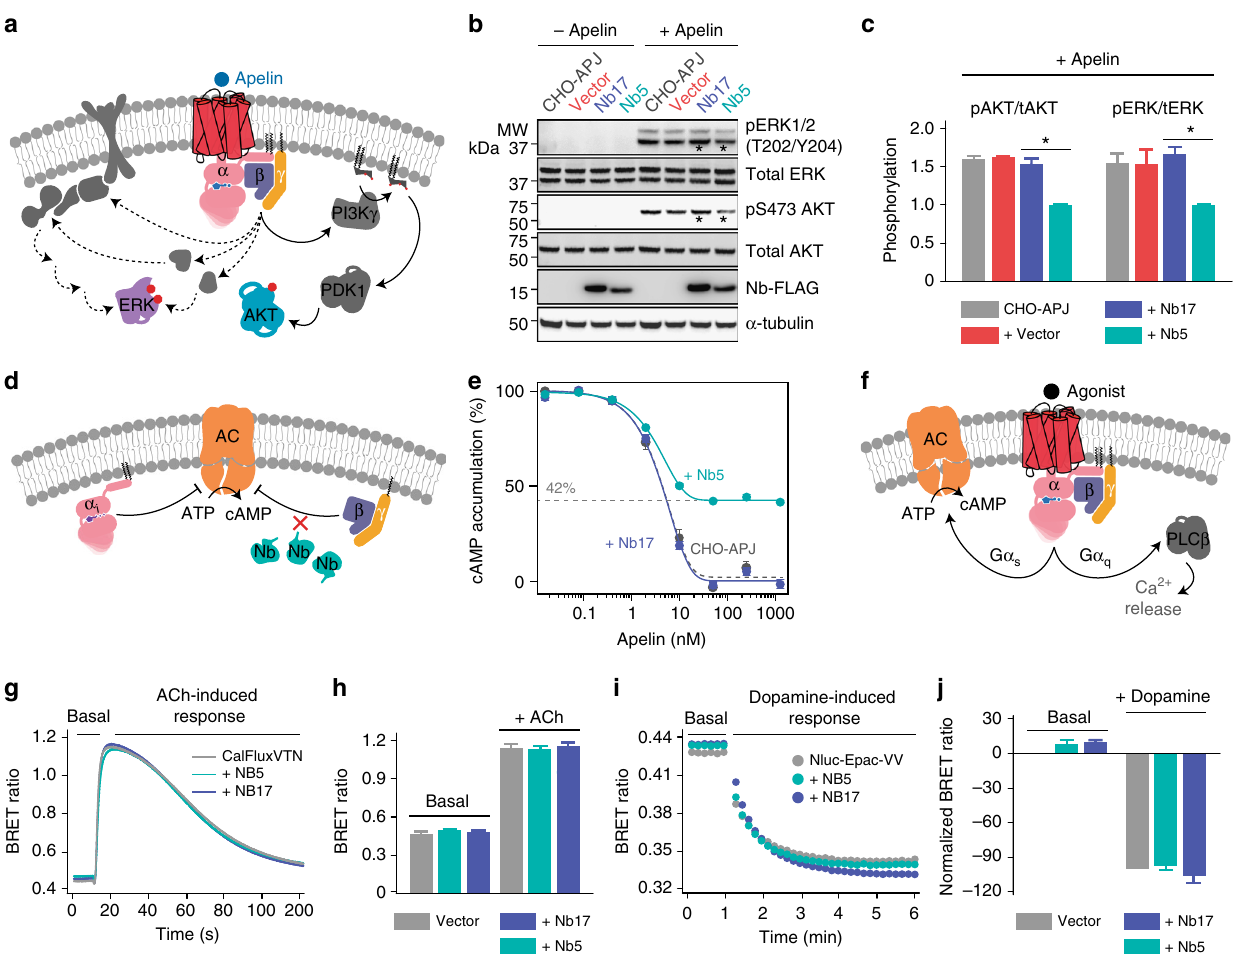
Fig. 6 Nb5 as a control-switch for GPCR-mediated G βγ signaling. a Schematic diagram of the GPCR-mediated G βγ signaling network that controls various cellular functions. b Parental CHO-APJ cells, CHO-APJ cells transfected with pcDNA3.1 ( + ) empty vector, transfected CHO-APJ-Nb5 and CHO-APJ-Nb17 cells were treated with 1 μ M apelin over 0 – 5 min to investigate the effect of Nb5 on the phosphorylation of ERK1/2 and AKT. Nb5 signi fi cantly decreased the phosphorylation of both ERK1/2 and AKT as compared to the Nb17 control (compare lanes marked with asterisks). Full blots are reported in Supplementary Figure 4b. c No signi fi cant effect of Nb17 transfection (purple) was observed on the phosphorylation of either ERK1/2 or AKT as compared to parental CHO-APJ cells (black) and CHO-APJ cells transfected with pcDNA3.1 ( + ) empty vector (red). Results are expressed as the mean ± SEM, n = 3 replicates, * P < 0.05, Student ’ s t -test. d Schematic diagram showing the effect of G α i and G βγ signaling on cellular cAMP levels. e Dose-response curves of apelin-induced inhibition of cAMP accumulation in parental CHO-APJ cells (grey) and CHO-APJ cells expressing either Nb5 (greencyan) or Nb17